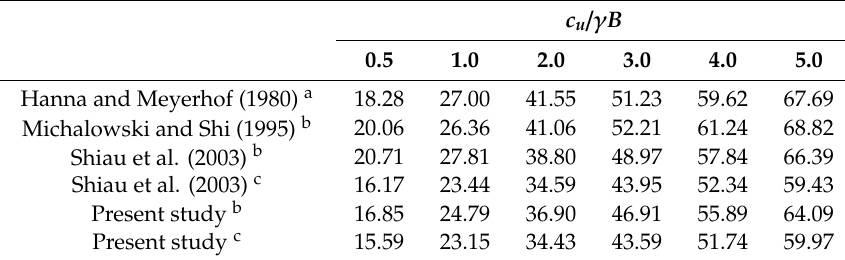
Table 3. Comparison of normalized bearing capacity, p u / ( γ B ), for a rough strip foundation on sand overlying clay ( H / B = 2, ϕ = 45 ◦